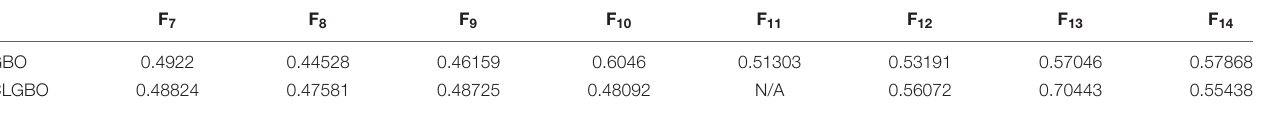
TABLE 5 | P -values of Wilcoxon rank sum